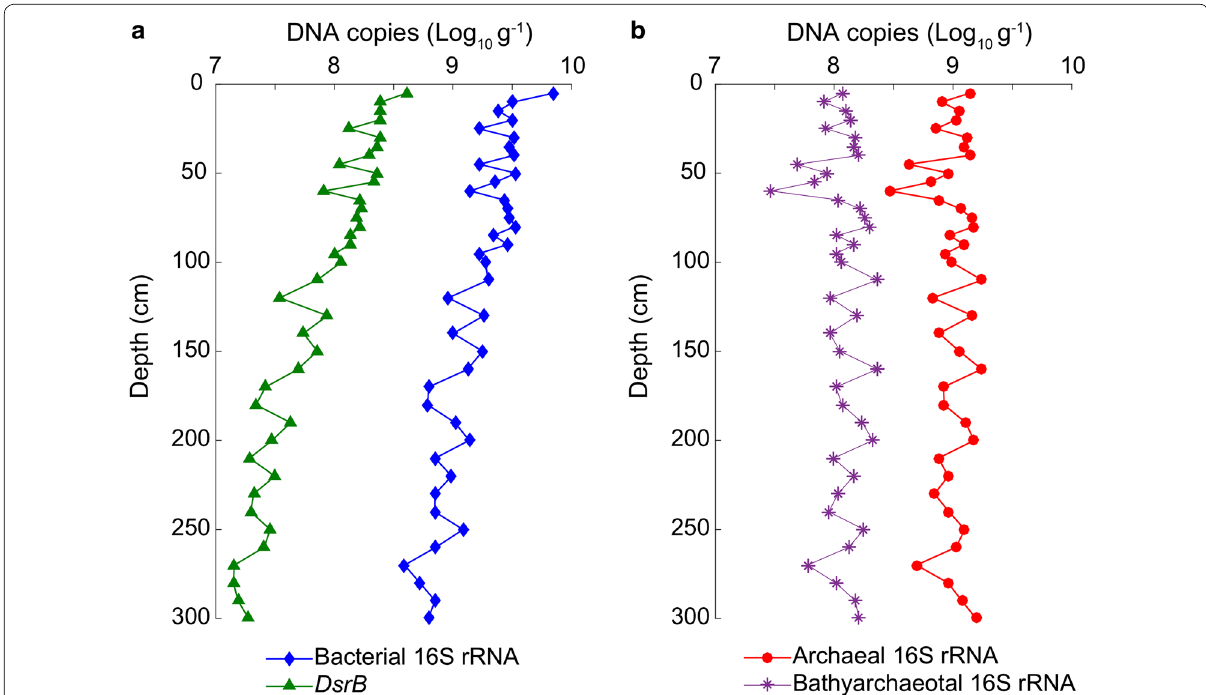
Fig. 2 Depth-variations in microbial 16S rRNA- and dsrB gene copies based on qPCR. a Bacterial 16S rRNA- and dsrB genes; b archaeal 16S rRNA- and bathyarchaeotal 16S rRNA